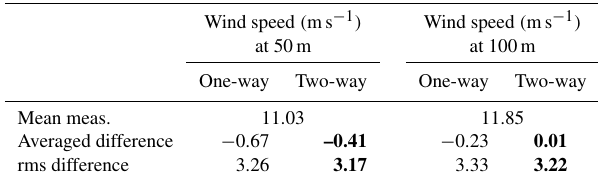
Table 2. Wind speed (ms − 1 ) bias and standard deviation of the one- and the two-way coupled COSMO model data against the FINO-1 data over the whole period (measured minus modelled). Bold means an improvement of the two-way coupled model